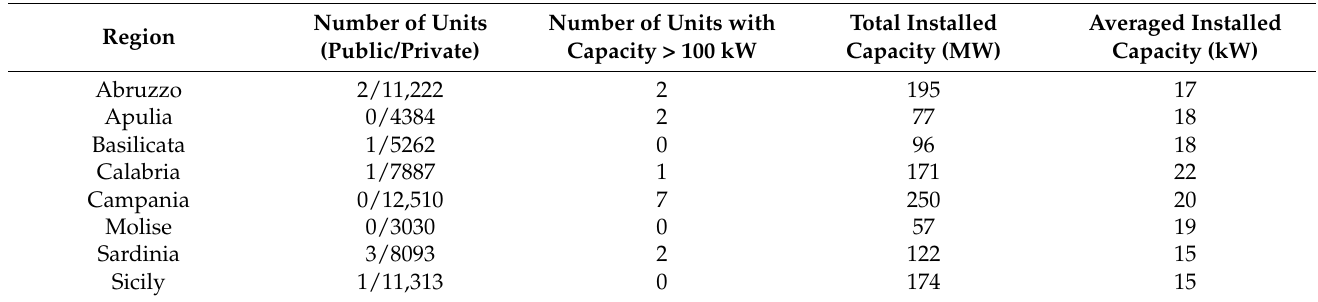
Table 13. Heat production from solid biomass in Southern Italy. Data partially adapted from GSE Atlaimpianti Internet. https://atla.gse.it/atlaimpianti/project/Atlaimpianti_Internet.html [53]. Number of Region